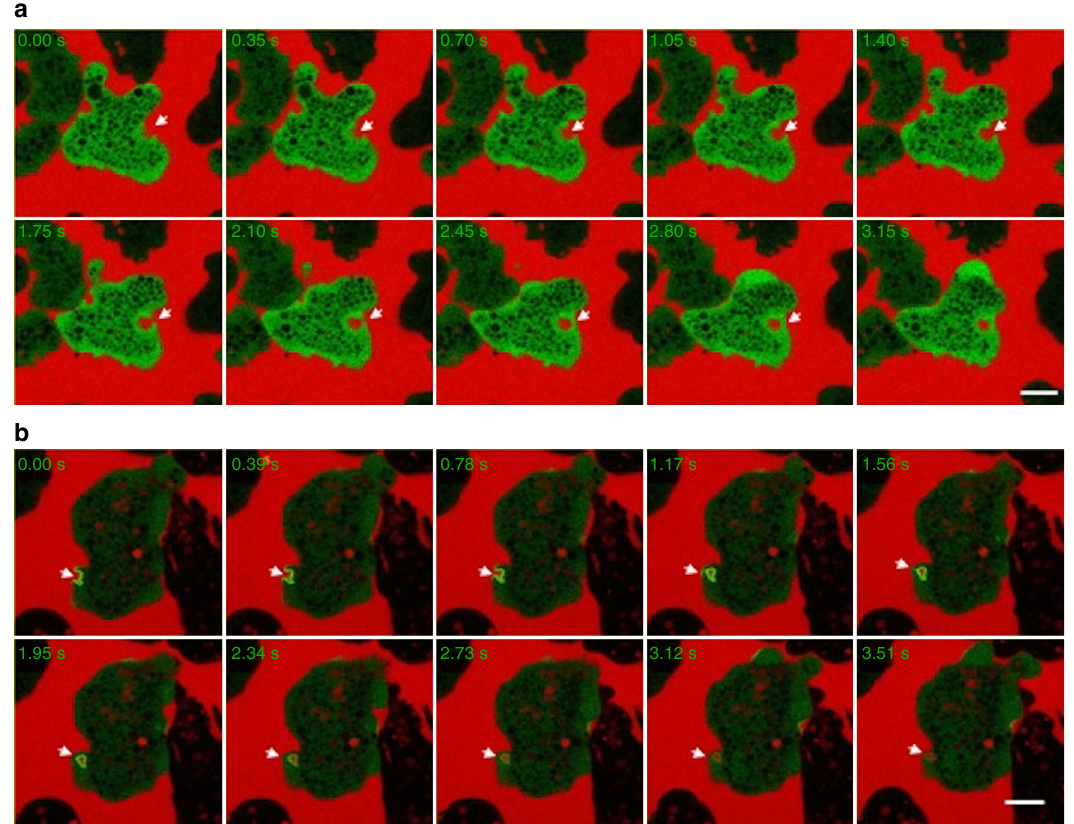
Fig. 5 Localization of GFP-tagged EhAGCK1 and EhAGCK2 during pinocytosis. Time series montage showing localization of a GFP-EhAGCK1 and b GFP-EhAGCK2 during pinocytosis of FITC dextran by amoebic trophozoites (the site of pinocytosis is marked with arrow ; Scale bar , 10 μ